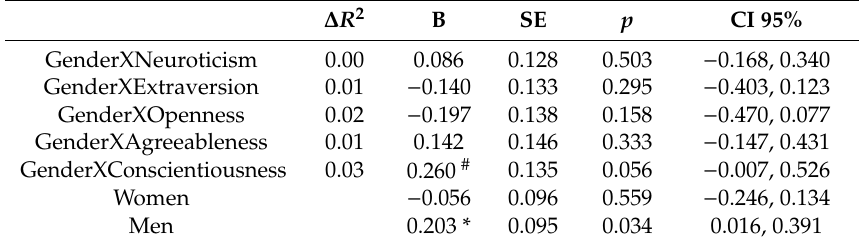
Table 5. Gender moderations in the relationship between personality traits and subjective-physical health.